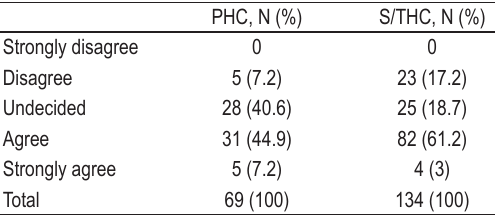
TABLE 5 . Examinees’ opinion on submitted